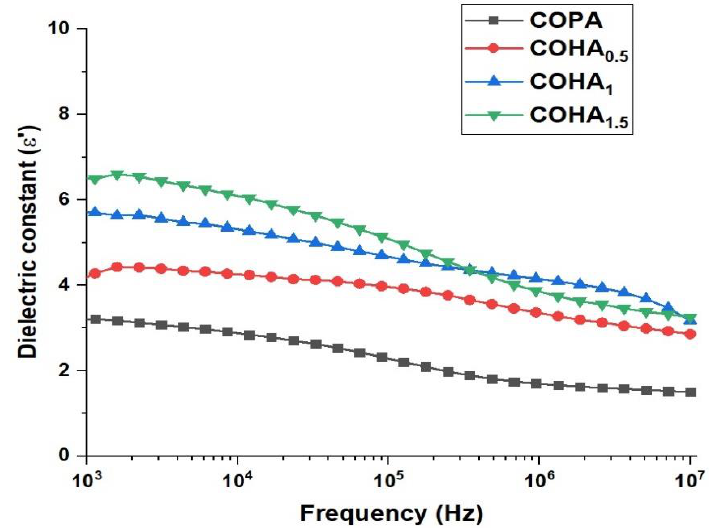
Figure 6. Frequency dependence of real permittivity (E’) for neat COPA and COHA nanocomposite fibers.